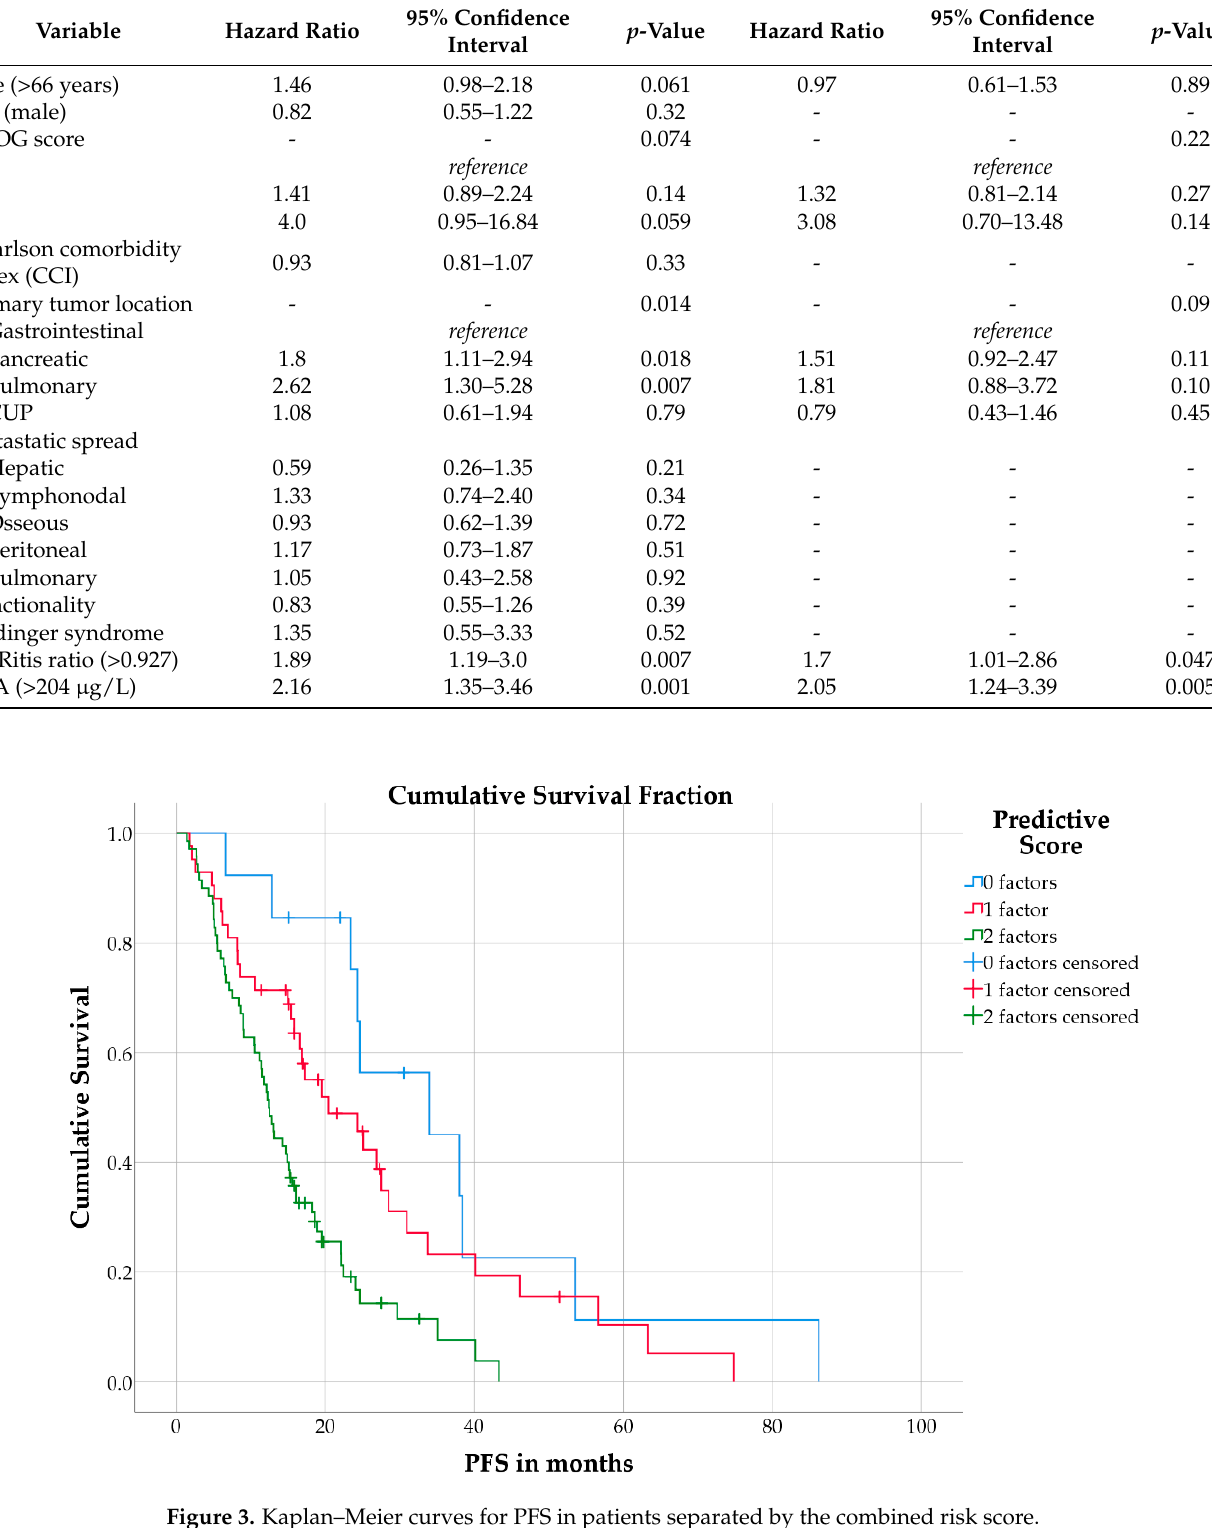
Figure 3. Kaplan–Meier curves for PFS in patients separated by the combined risk score.